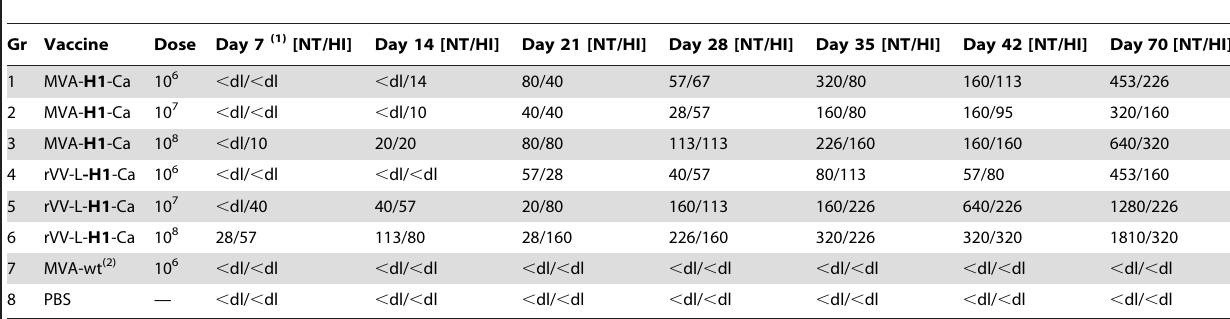
Table 3. Geometric mean neutralization (NT) and hemagglutination inhibitions (HI) titers of mouse sera after single dose immunizations with the live vectors.